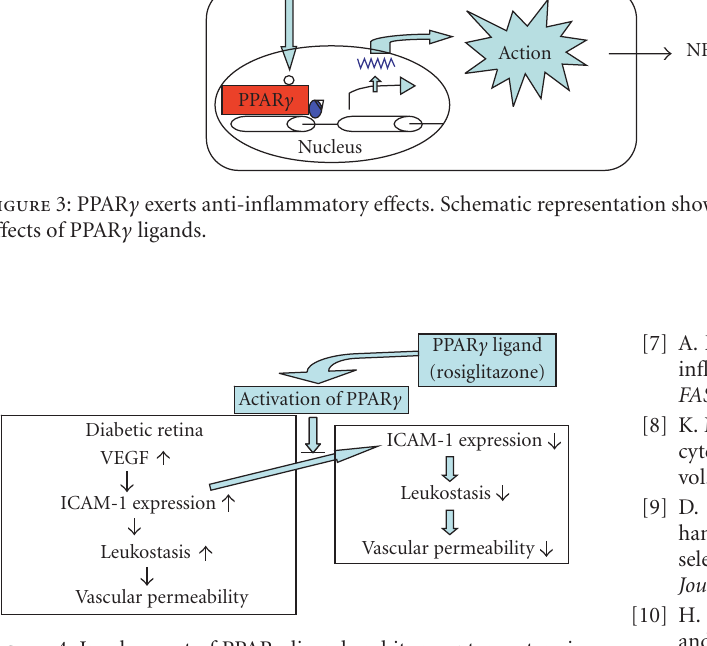
Figure 4: Involvement of PPAR γ ligand and its receptor system in retinal leukostasis and vacular permeability. Schematic representa- tion showing the role of PPAR γ system in the retinal leukostasis and vascular permeability in diabetic